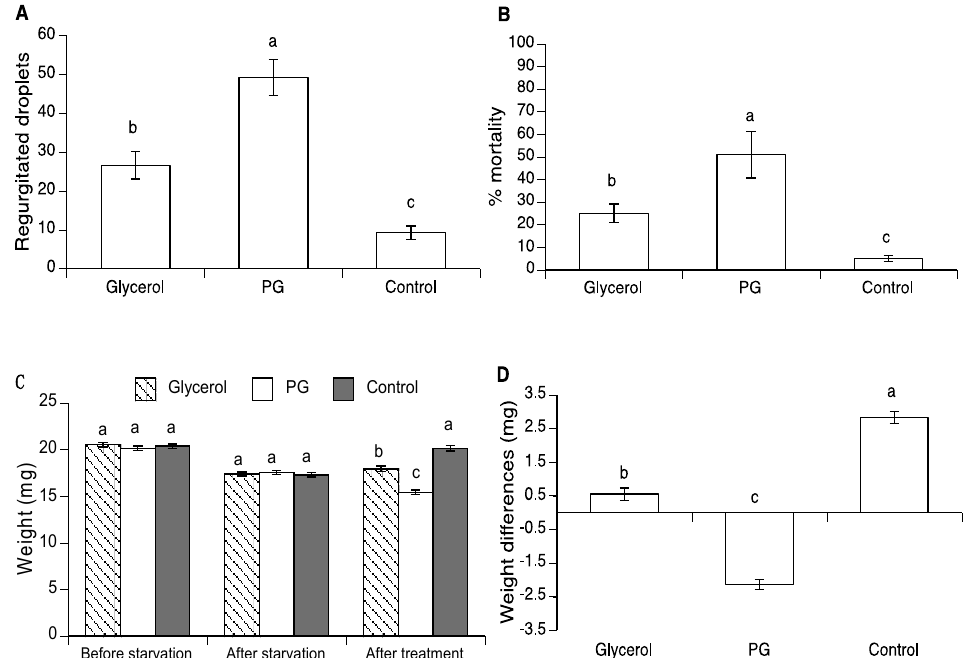
Figure 2. ( A ) Mean ( ± SE) number of regurgitated droplets deposited on cup walls by A. ludens exposed to 4.18 M PG or 4.18 M glycerol in mixtures with sucrose. ( B ) Percentage of mortality observed at 72 h post-treatment. ( C ) Mean ( ± SE) body weight of flies before starvation, prior to treatment (after starvation), and after treatment. ( D ) Mean ( ± SE) difference in body weight at 24 h after treatment. Columns headed by the same letter are not significantly different (GLM post-hoc contrasts, at the p = 0.05 level).